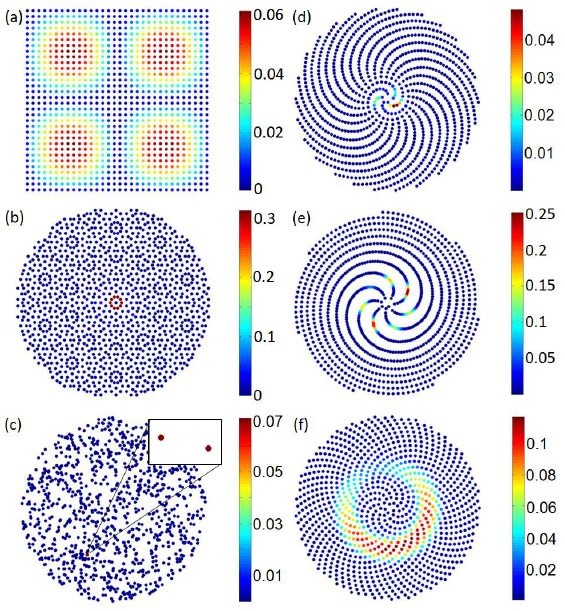
Figure 18. Example of long-lived ( Re Λ (cid:39) − 1) eigenvectors with large IPR value in each case of ( a ) N = 1024 square array ( Λ = − 0.9930 + 0.8807 i , IPR = 0.0021 ) ; ( b ) N = 1108 Penrose array ( Λ = − 0.9980 + 1.3426 i , IPR = 0.0113 ) ; ( c ) N = 1000 random array ( Λ = − 0.9989 − 3877 i , IPR = 0.5 ) ; ( d ) N = 1000 µ -spiral array ( Λ = − 0.9596 + 1.0960 i , IPR = 0.1076 ) ; ( e ) N = 1000 π -spiral array ( Λ = − 1.0000 + 5.4620 i , IPR = 0.0244 ) ; and ( f ) N = 1000 τ -spiral array ( Λ = − 0.9846 + 0.4464 i , IPR = 0.0054 ) . The S λ 2 values are all equal to 4.19 and color-coding is the vector norm of the eigenvector component ( x , y , z ) associated with each